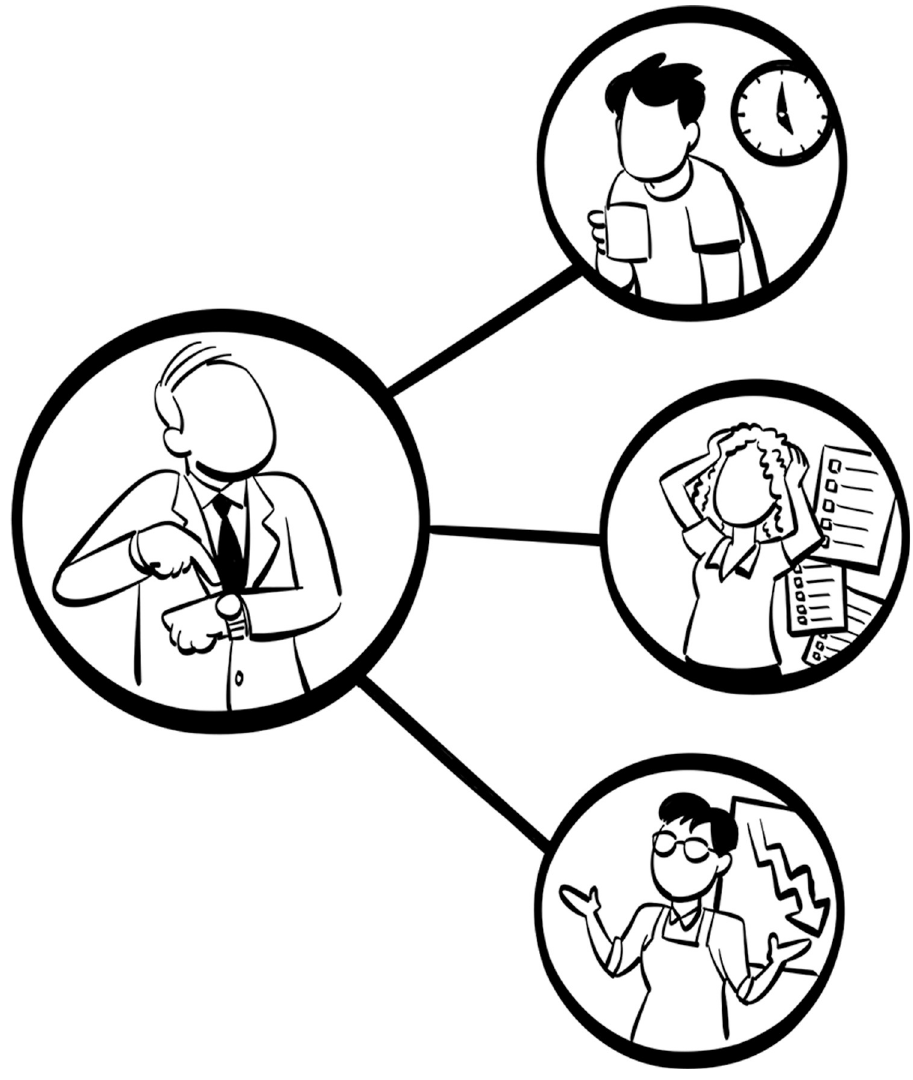
Fig 2. Personal boundaries?